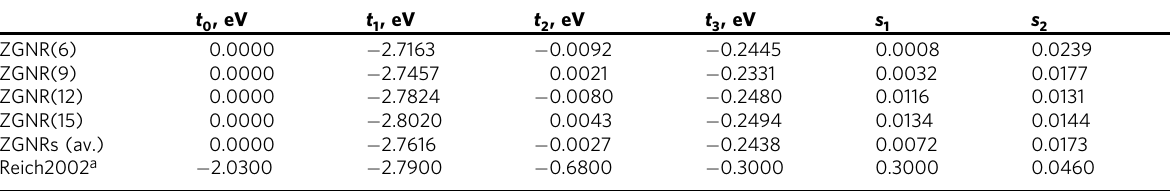
Table 1 Tight-binding parameters for ZGNRs and armchair SWCNTs.